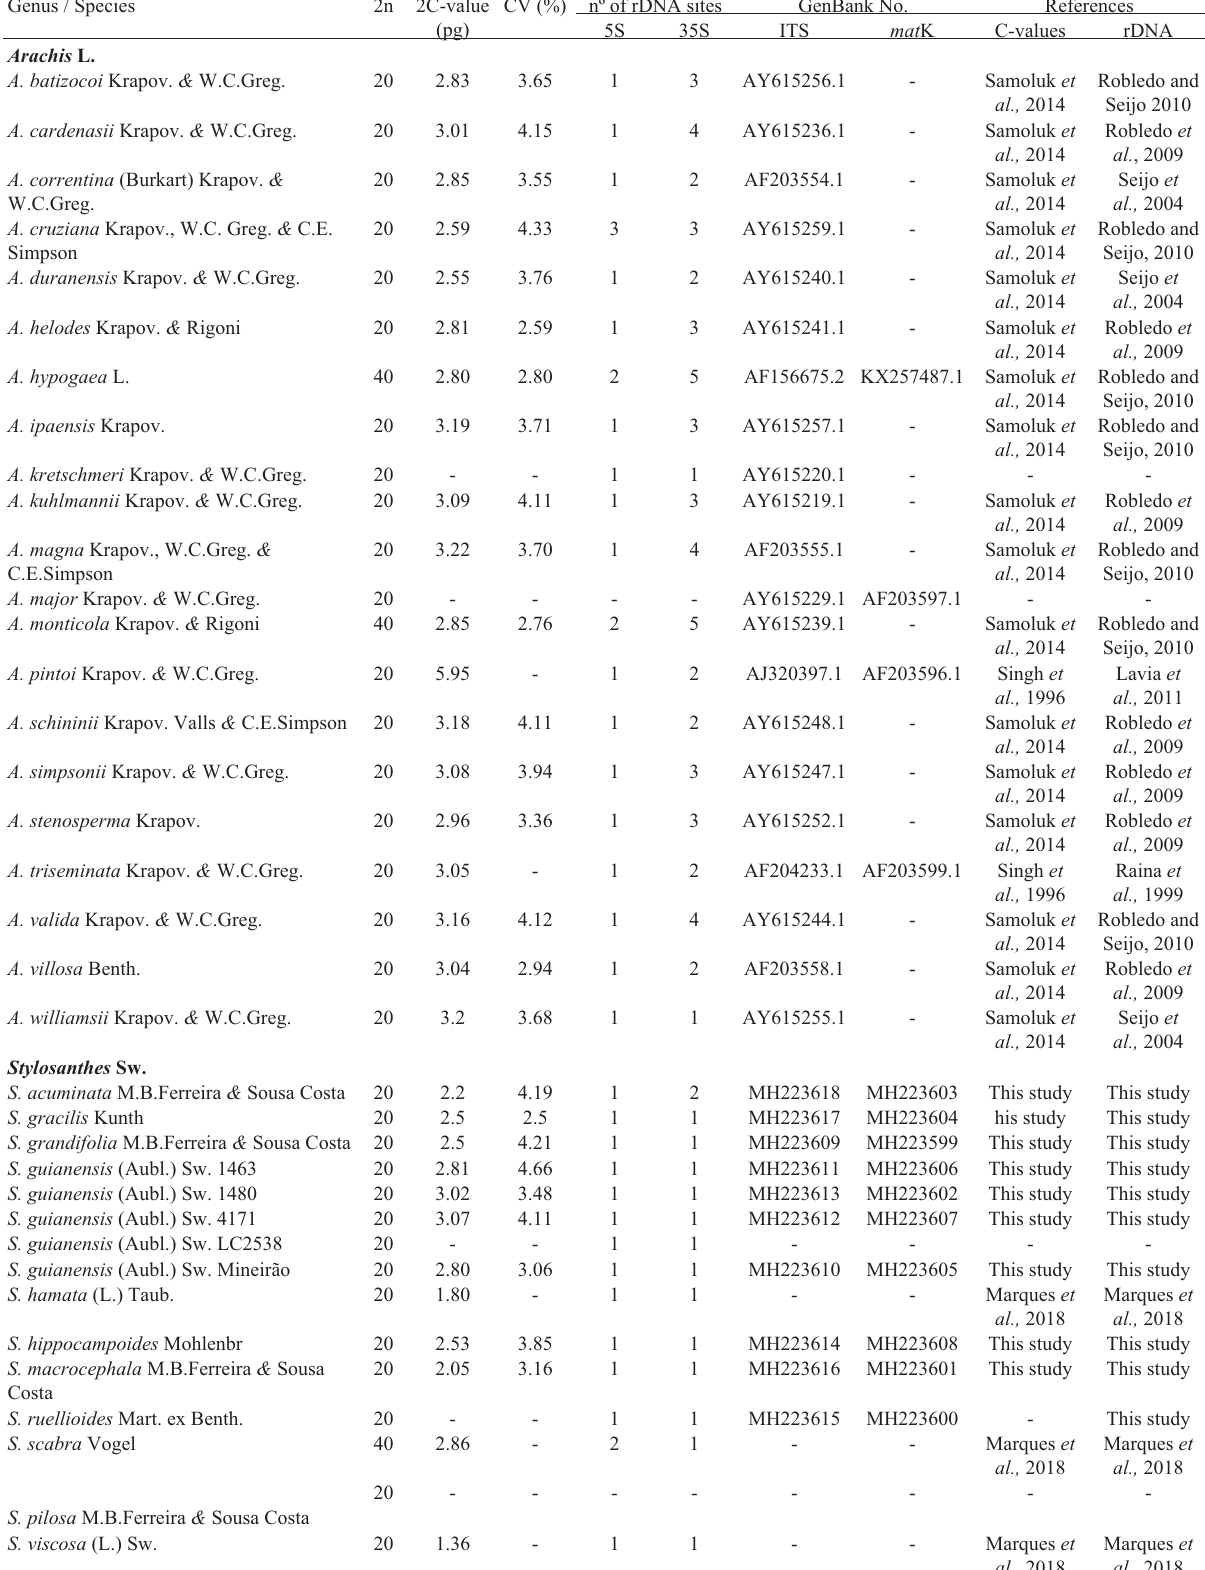
Table 1 - Species analyzed with their respective chromosome numbers, DNA content (average and coefficient of variation), and GenBank accession numbers. Genus /